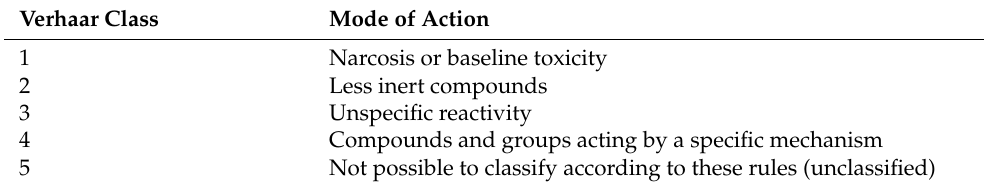
Table 8. Verhaar classes for fish acute toxicity Mechanism of Action (MoA). Verhaar Class Mode of Action 1 Narcosis or baseline